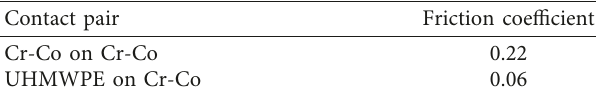
Figure 3: (a) Assembly of TMJ prostheses fixed to the right half of the mandibular bone and (b) meshing of the TMJ mandibular component. Notice the mesh refinement at the contact interface. Table 4: Coulomb’s friction coefficients for different prosthetic contact pairs